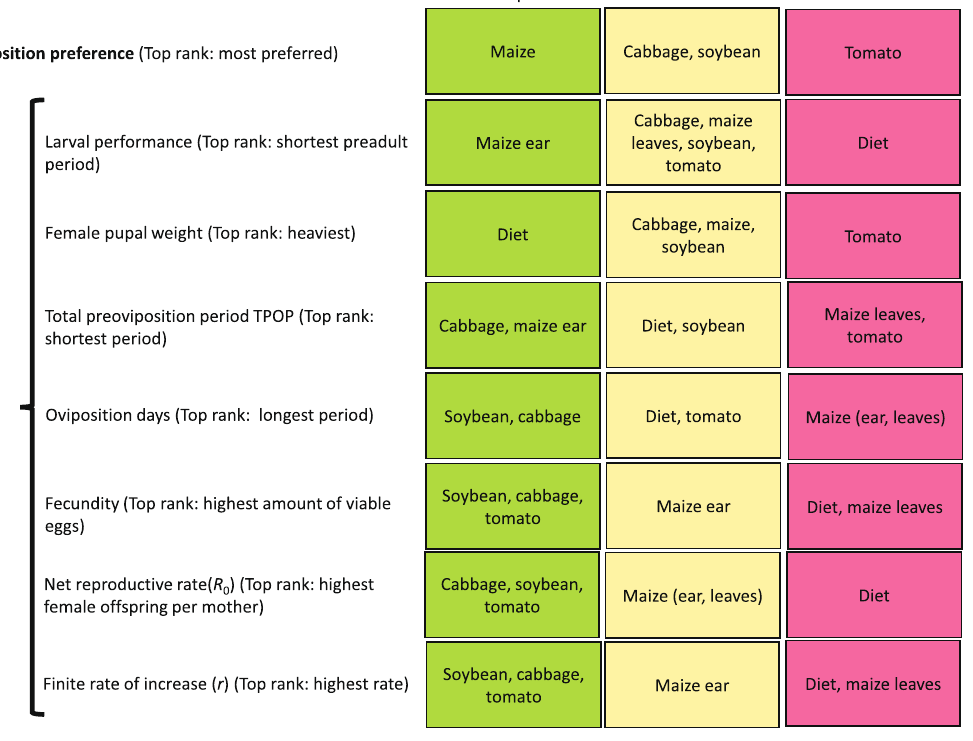
Figure 6. Summary of the preference and performance of the fall armyworm, Spodoptera frugiperda fed on cabbage, maize ear, maize leaves, artificial diet, soybean, and